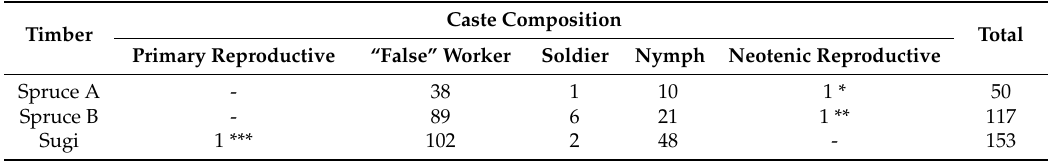
Table 3. Caste composition of drywood termite colony from each